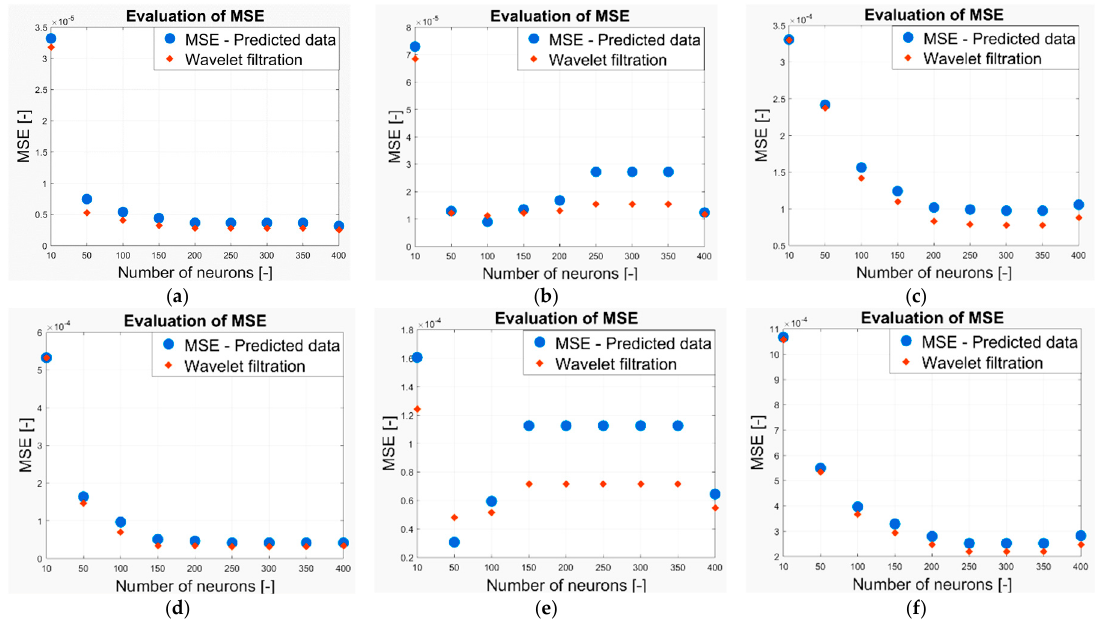
Figure 24. The Mean Squared Error (MSE) evaluation for the CO 2 prediction ( a ) 6–13 May 2018, ( b ) 15